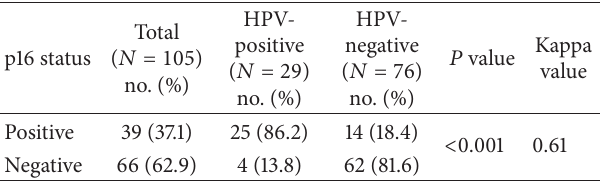
Table 2: Correlation between HPV in situ hybridization and p16 immunohistochemistry in esophageal squamous cell